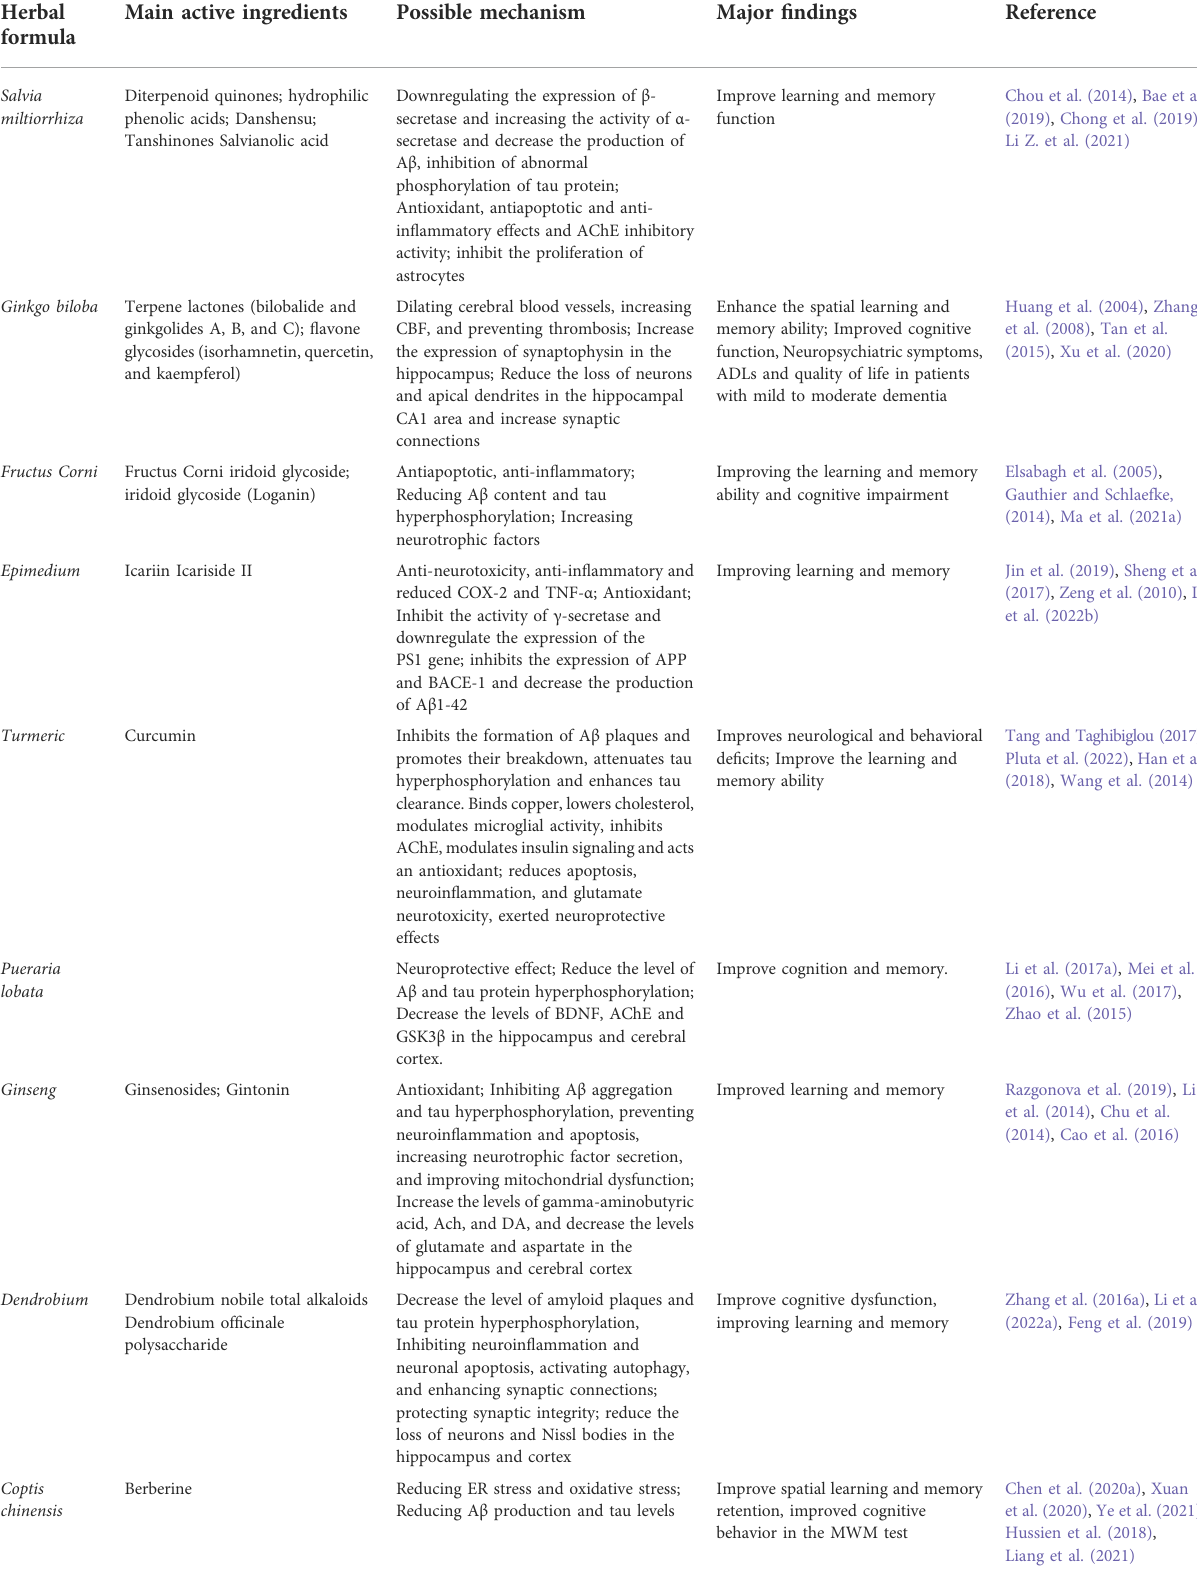
TABLE 2 Treatment of Alzheimer ’ s disease with single TCMs and their active